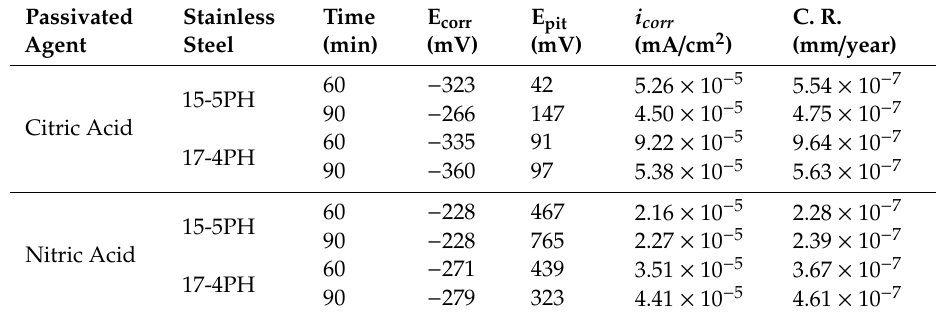
Table 4. Potentiodynamic polarization parameters in stainless steels passivated at 49 ◦ C, in 5 wt. % NaCl.